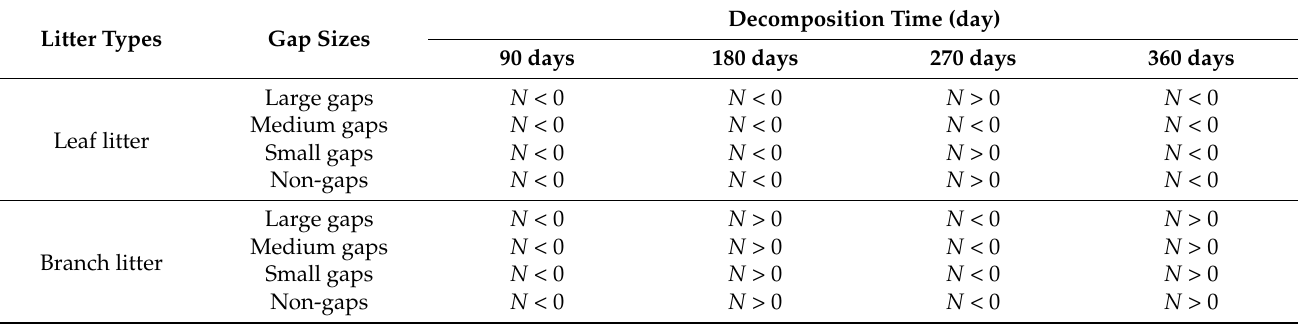
Table A4. Total carbon release of litter at different decomposition stages in canopy gaps and non-gaps.